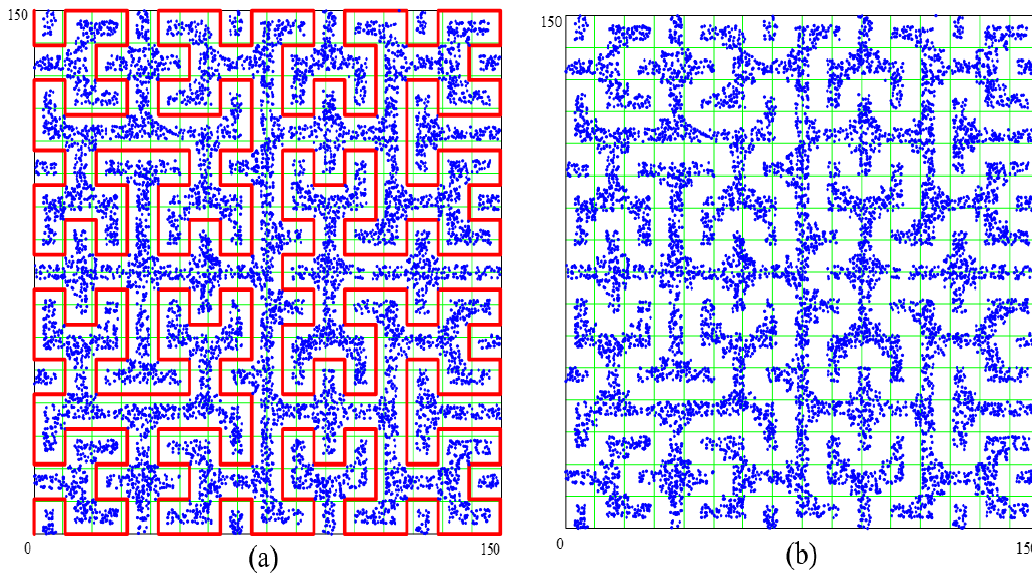
Figure 5. Structure model based on a fragment of the ( a ) Hilbert curve, ( b ) Network